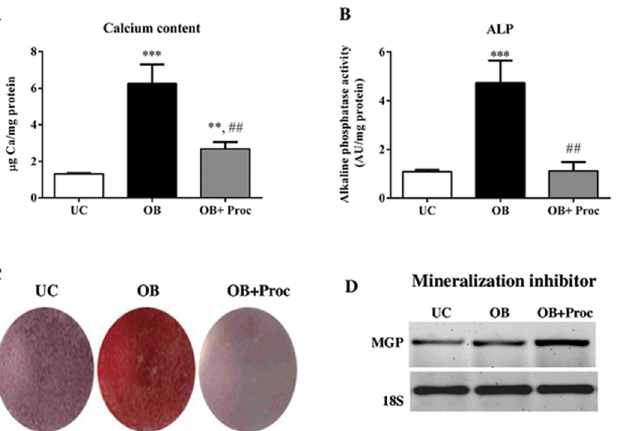
Fig 3. Procaine decreases mineralization of osteo/odontoblasts differentiated from mesenchymal stem cells (MSC). A) Calcium content and B) alkaline phosphatase activity were significantly increased after osteo/odontogenic stimulus (OB) ( * p < 0.05 vs. undifferentiated cells (UC)) at 21 days. Procaine addition (OB +Proc) significantly decreased calcium content and alkaline phosphatase activity after 21 days of differentiation ( (cid:129) p < 0.05 vs. OB cells). C) Alizarin red staining increased after osteo/odontoblasts differentiation (OB) while procaine addition (OB+Proc) significantly decreased mineralization during the differentiation process. Images are representative of three cultures. D) MGP gene expression was increased after procaine administration, impairing the mineralization process in OB cells. The size and intensity of amplicon was analyzed on agarose gel (2%). Ribosomal 18S expression was used as